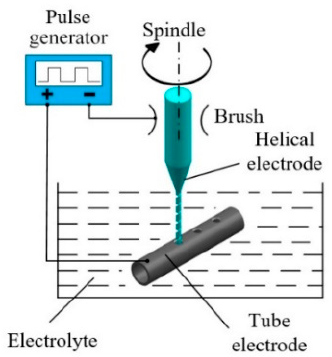
Figure 2. Schematic of electrochemical micro-drilling (ECMD) with a helical drill on a tube electrode.